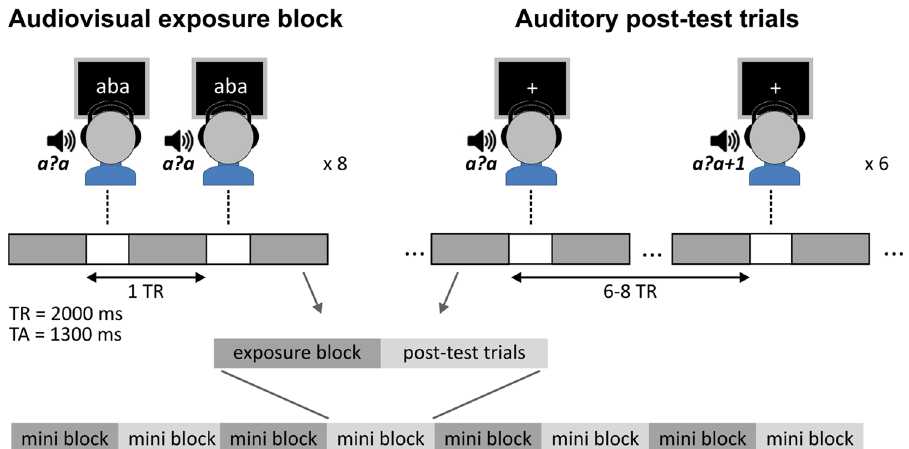
Figure 1. Experimental Design. Schematic overview of the fMRI stimulation protocol and one mini block including an audiovisual exposure block (‘aba’ example) containing 8 presentations of the ambiguous /a?a/ sound together with ‘aba’ text, followed by 6 auditory post-test trials involving the slow event-related presentation of the /a?a/ sound and its two closest neighbours on the continuum. The experiment consisted of 3 runs that each contained 8 of these mini